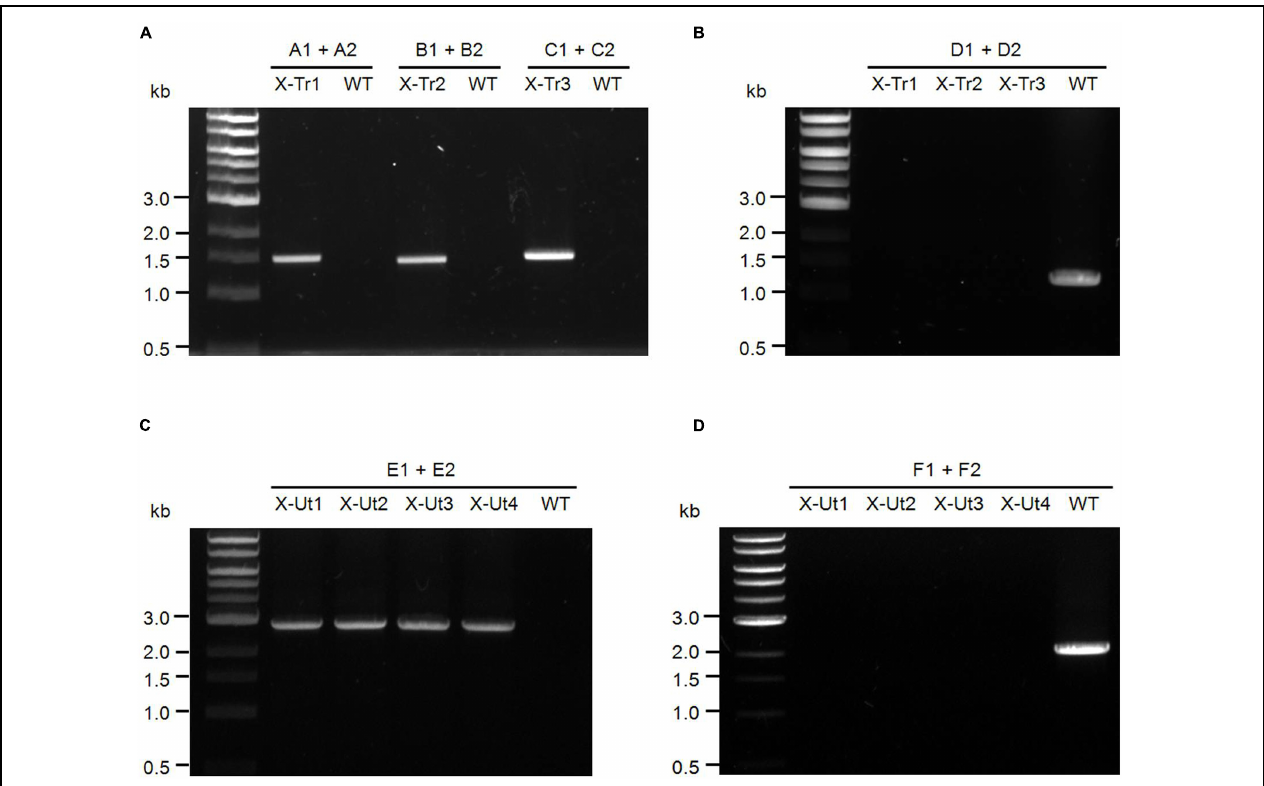
FIGURE 3 | Test of insertion of heterologous genes and chromosomal segregation for Synechocystis strains. (A) Primers upstream and downstream of the xylose transporter genes x ylE (A1–A2), galP (B1–B2), and glf (C1–C2) were used to confirm the presence of the inserts in the respective transformants (Figure 2A) and also in the WT strain as the negative control. In the presence of the templates, primers A1–A2, B1–B2, and C1–C2 produced fragments of ∼ 1.48, ∼ 1.40, and ∼ 1.42 kb, respectively. (B) Primers upstream and downstream of intact neutral site 1 (D1–D2) were used to examine the chromosomal segregation for respective transformants (Figure 2A) along with the WT strain as a positive control. In the absence of uninterrupted neutral site 1, primers D1–D2 failed to produce PCR products in the transformants, whereas the WT strain yielded a ∼ 1.20-kb product. (C) Primers upstream and downstream of the xylose catabolic genes xylAB (E1–E2) were used to examine the insert in respective transformants (Figure 2B) and also in the WT strain as the negative control. In the presence of the template, primers E1–E2 produced a product of ∼ 2.85 kb. (D) Primers upstream and downstream of intact neutral site 2 (F1–F2) were used to check the chromosomal segregation for respective transformants (Figure 2B) along with the WT strain as the positive control. In the absence of uninterrupted neutral site 2, primers F1–F2 failed to produce PCR products in the transformants, whereas the WT strain yielded a ∼ 1.93-kb product.